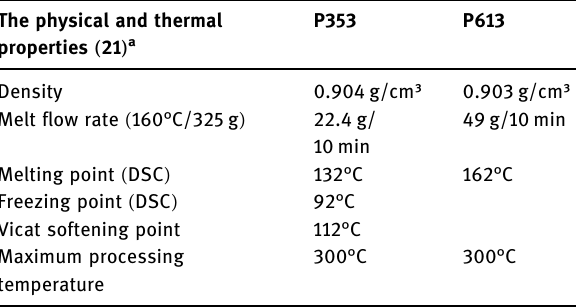
Table 1: The physical and thermal properties of Fusabond